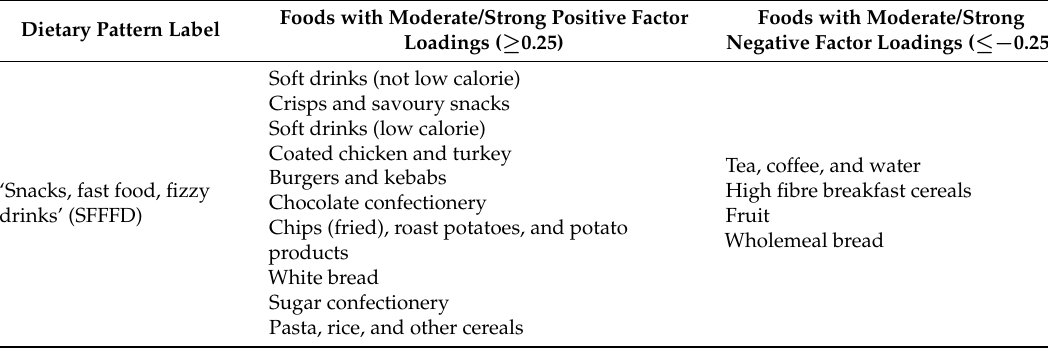
Table 4. Food variables characterising each dietary pattern (NDNS 2008–2012). Dietary Pattern